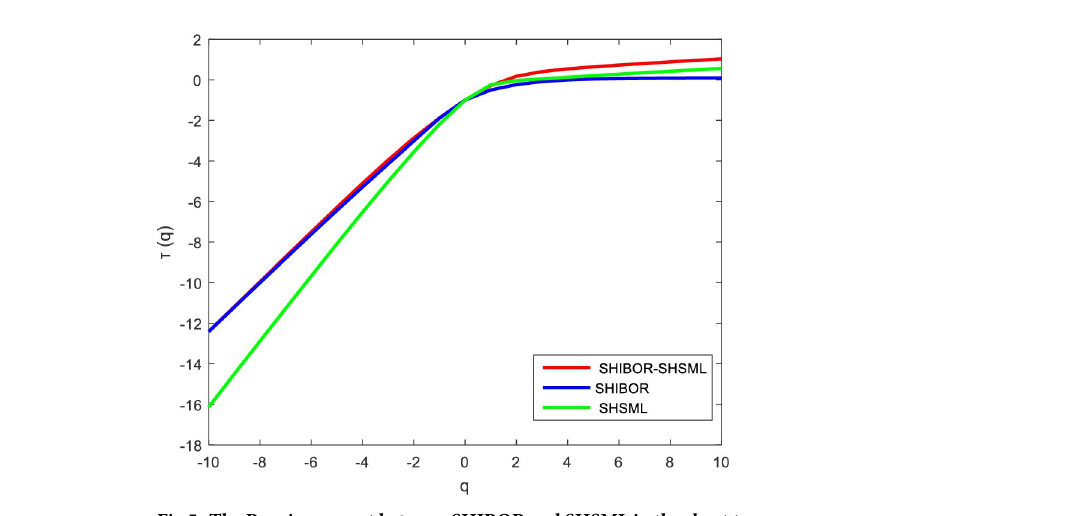
Fig 5. The Renyi exponent between SHIBOR and SHSML in the short term.